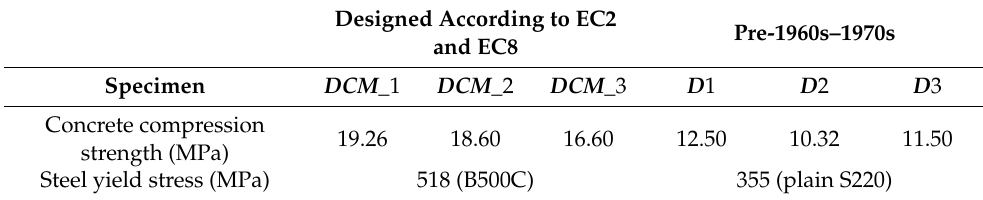
Table 2. Concrete compression strength and steel yield stress of the